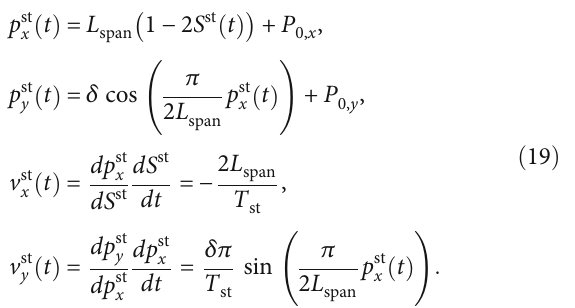
Figure 9: Derivation block diagram of the least-squares